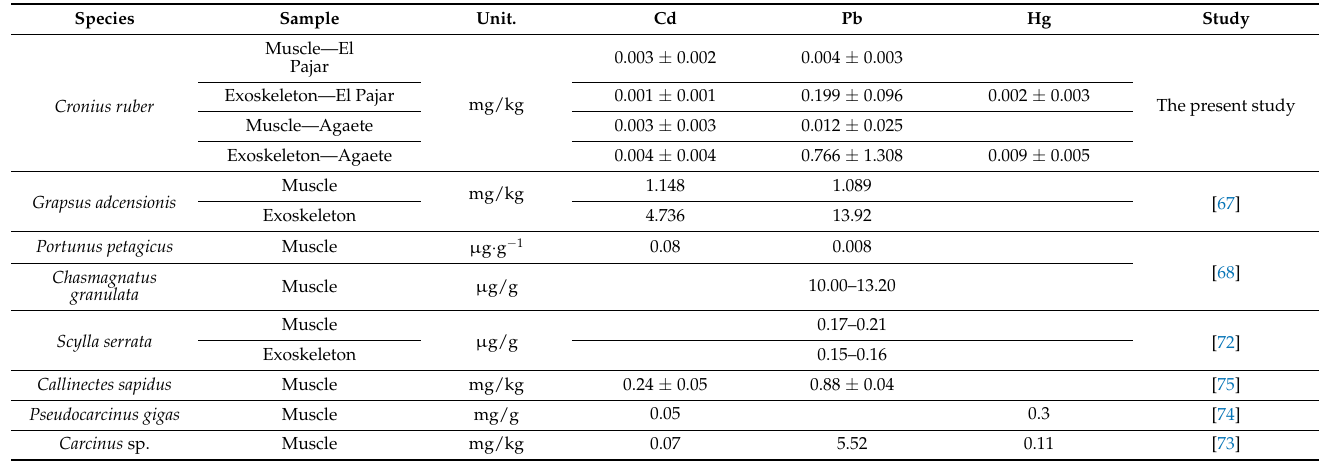
Table 6. Comparison of the mean concentrations of heavy metals in the present study with others in different parts of the world.